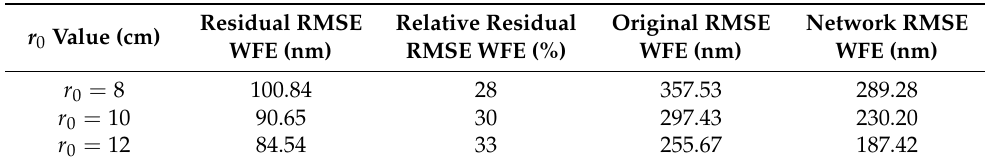
Table 1. Results obtained for the MLP model. Each value is obtained as the mean value over the 3000 samples of the test dataset.